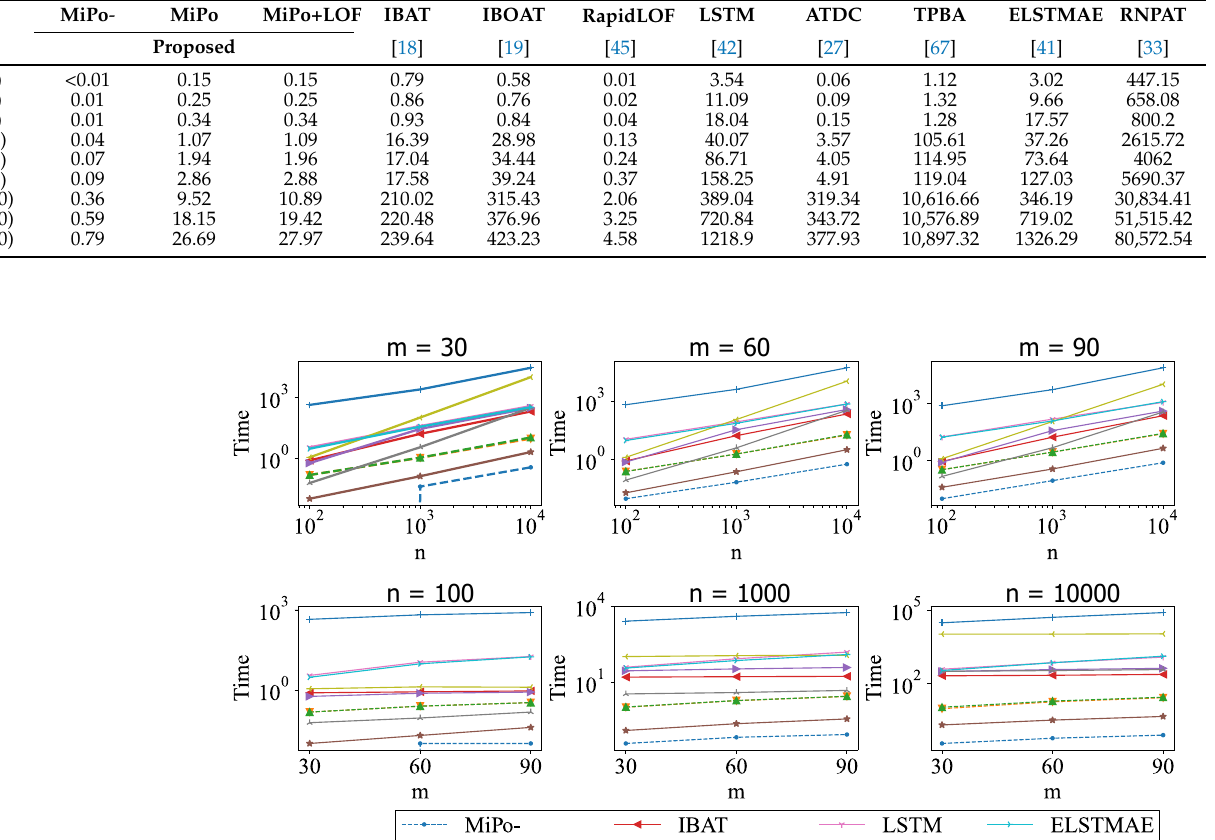
Table 4. Running time (s) of MiPo-, MiPo, MiPo+LOF, and baseline trajectory outlier detector.